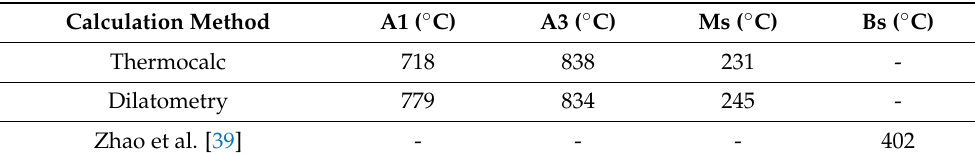
Table 3. Calculated (Themocalc) and estimated (from dilatometry measured with spot welded K-thermocouple) transformation temperatures of the investigated alloys.